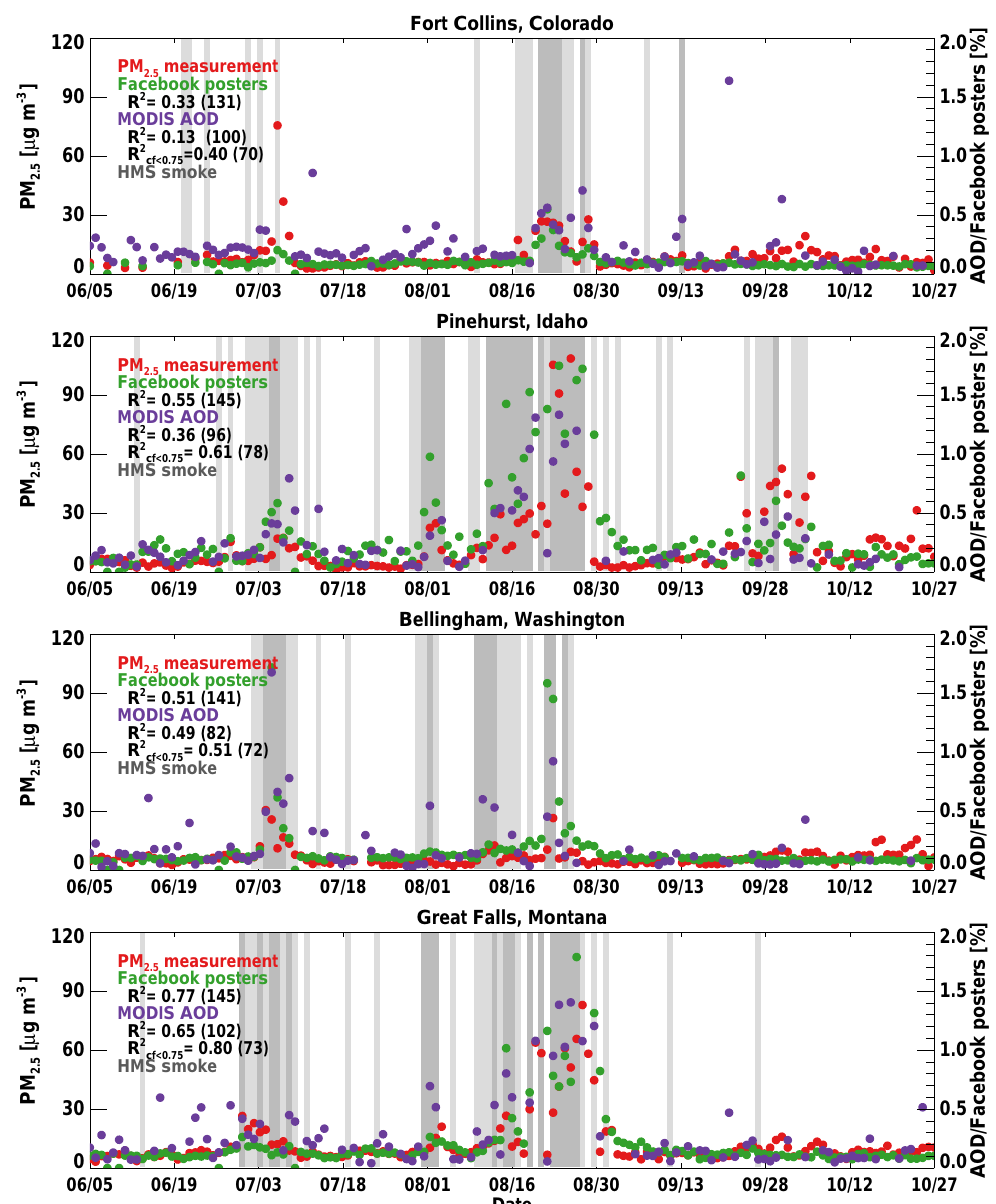
Figure 2. Time series of measured surface PM 2 . 5 concentrations (red), gridded and population-weighted percent of Facebook posters (green), MODIS AOD (purple), and days with HMS-denoted light (light gray) and moderate to thick (dark gray) smoke at the following locations for 5 June to 27 October 2015: (a) Fort Collins, CO; (b) Pinehurst, ID; (c) Bellingham, WA; and (d) Great Falls, MT. R 2 values for each dataset with the surface measurement are given along with the number of days available for the calculation noted in